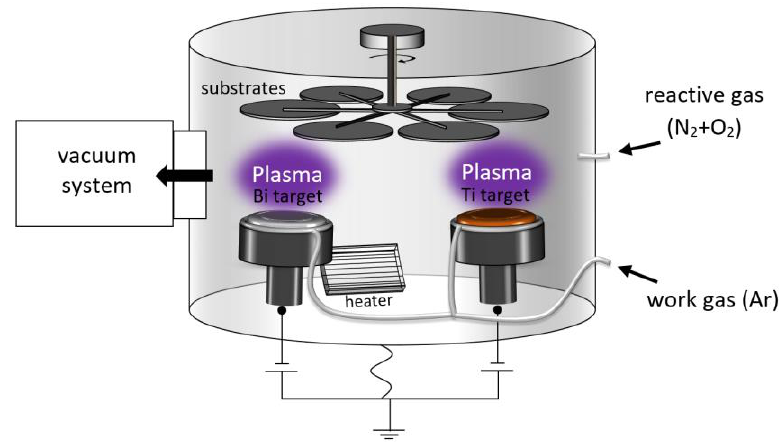
Figure 1. Unbalanced magnetron deposition system used for reactive sputtering of Bi/Bi 2 O 3 /TiO 2 :N layers.